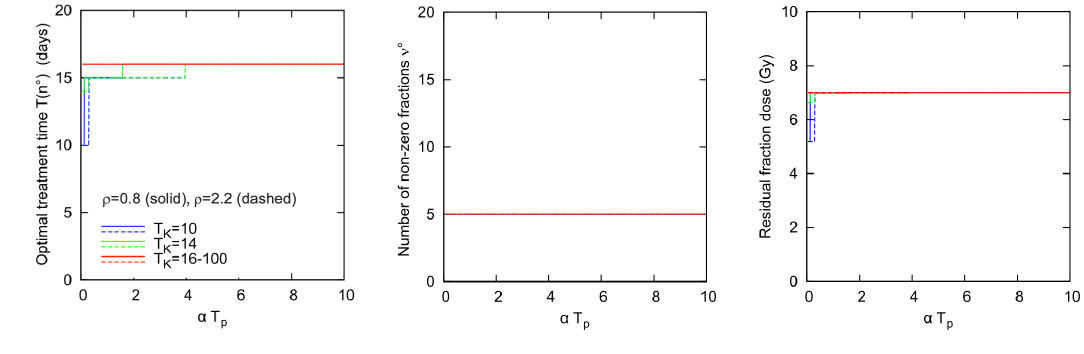
Figure 5. Optimal protocols for slowly proliferating tumors, ρ < ρ l , as a function of α T P , for different ρ and T K . Daily dose upper bound d M = 7